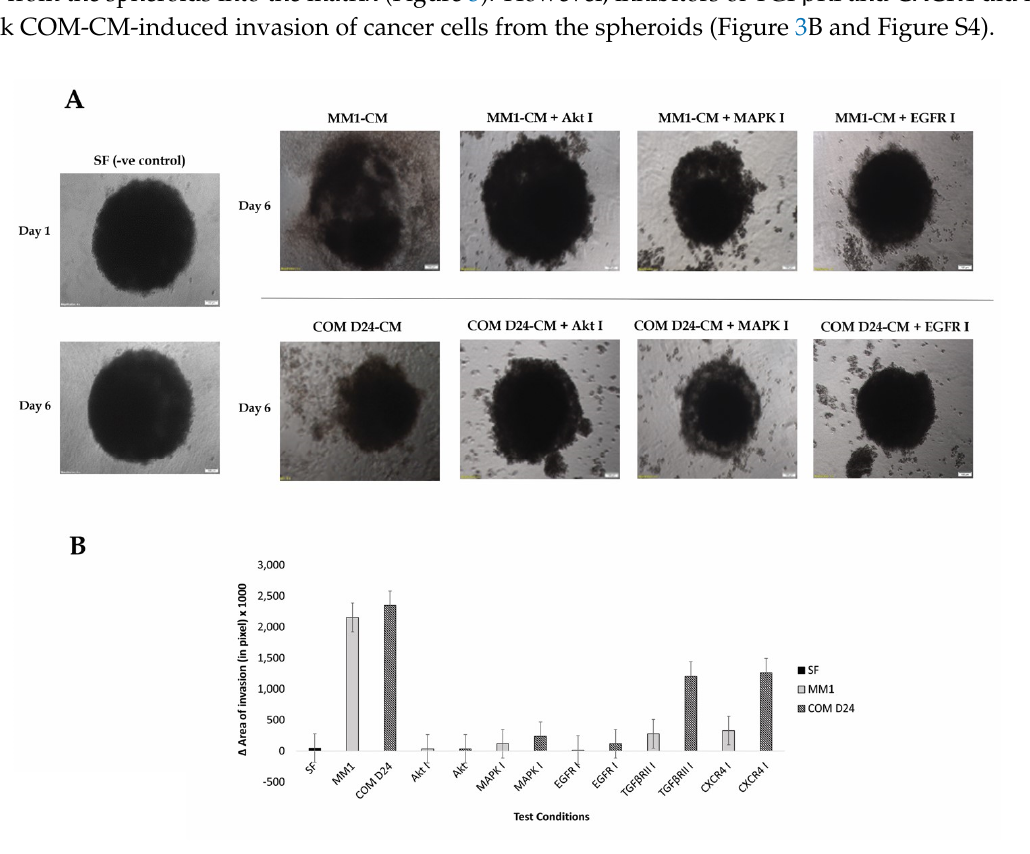
Figure 3. TYS cells invasion from their spheroids in response to fibroblast CM ± the inhibitors. ( A ) TYS spheroids were embedded into a collagen matrix followed by treatment with fibroblast CM with or without the inhibitors. Images of the invasive TYS cells from the spheroids were captured after day 6 using an inverted microscope with a 4X objective lens. Images of the TYS spheroids treated with TGF β RI inhibitor and CXCR4 inhibitor are presented in the Supplementary Material (Figure S4). SF-MEM-treated TYS spheroids were regarded as a negative control. Scale bar = 100 µ m. ( B ) Graphical representation of TYS invasion into the collagen matrix from the spheroids in response to fibroblast CM ± the inhibitors after day 6. COM-CM stimulated TYS invasion from the spheroids into the matrix, more than the negative control (SF-MEM-treated cells) and MM1-CM. The Akt and EGFR inhibitors were the most effective inhibitors in blocking CM-induced TYS invasion. The area of invasion (out from the edge of the spheroid) was calculated using ImageJ software.